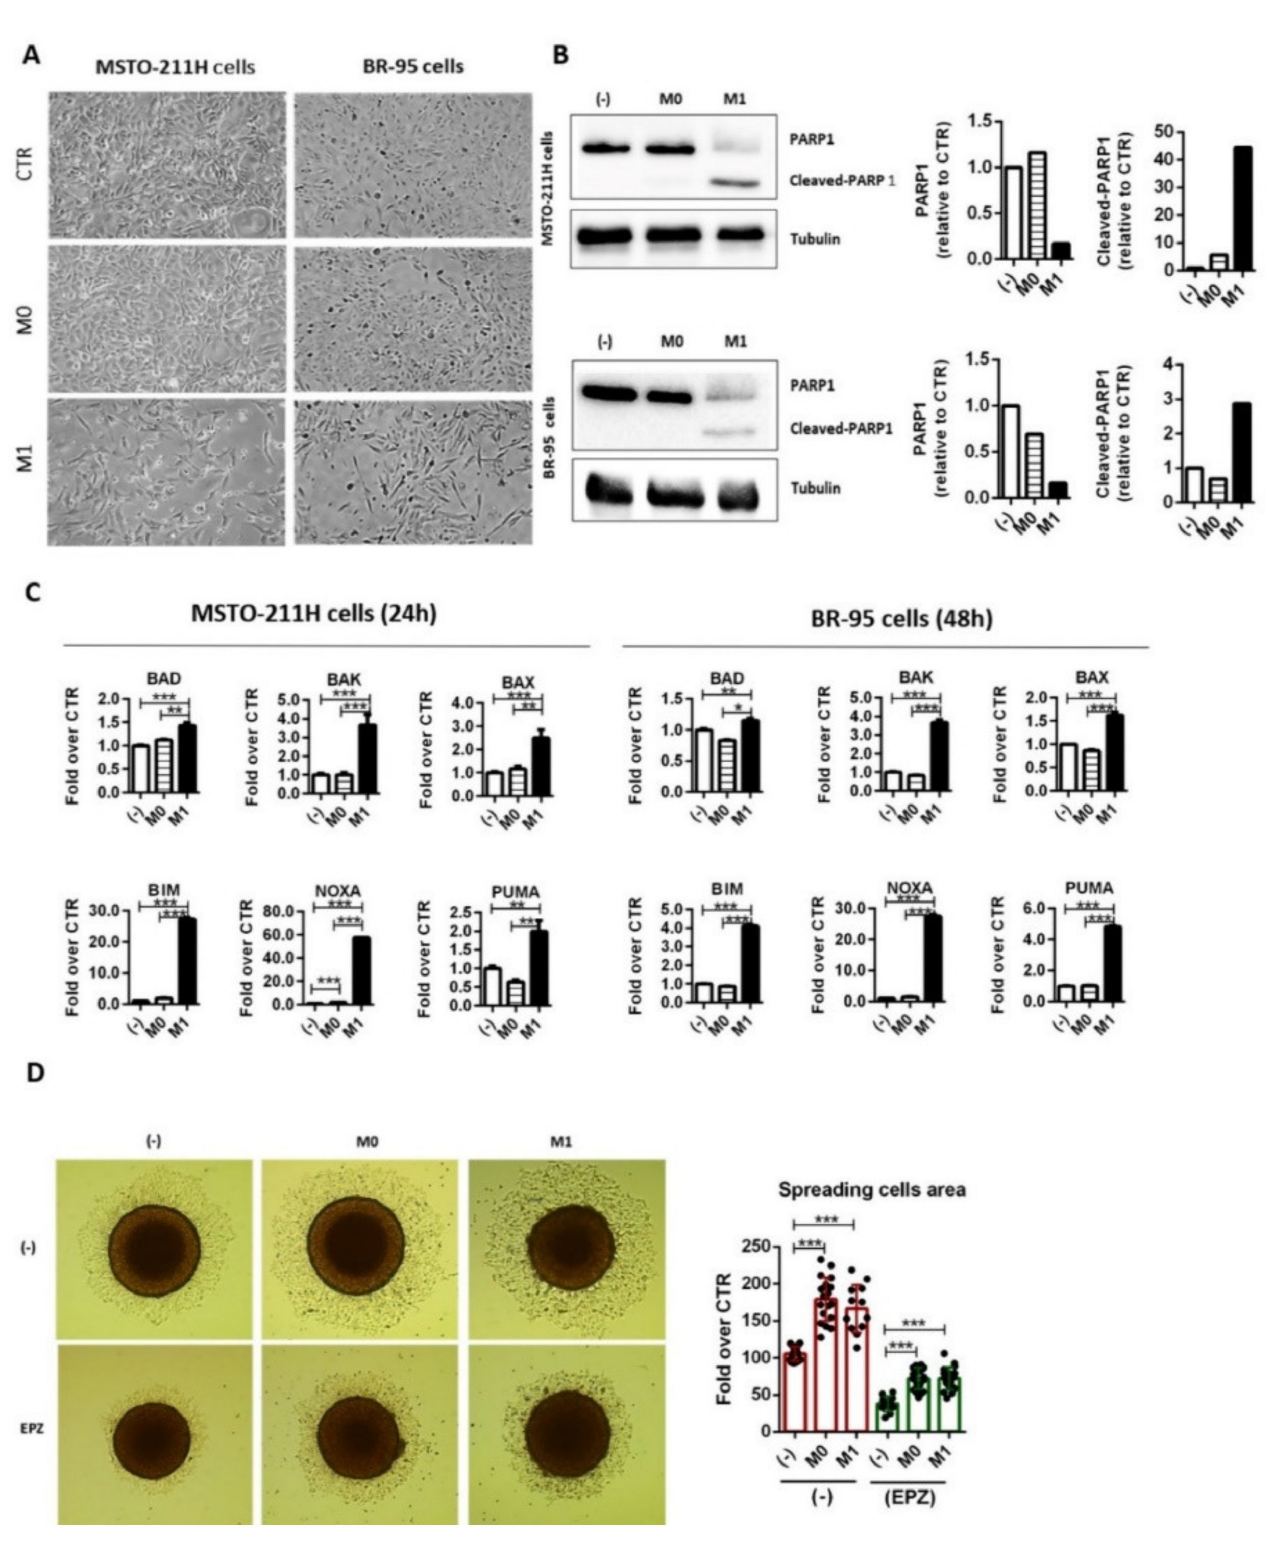
Figure 6. M1-polarized monocytes impair the survival of MPM cells grown as monolayer but not as MCS. ( A , B ) MSTO-211H and BR-95 cells were, respectively, cultured for 48 h or 72 h with 50% of control medium (ctr), M0, and M1-conditioned medium; ( A ) representative optical microscope images are shown. Magnification: 10 × ; ( B ) total proteins were extracted and resolved by 7% SDS-PAGE. PARP1 cleavages were analyzed by Western Blot. Tubulin was used as loading control; ( C ) total RNA was extracted from MSTO-211H cells and BR-95 cells treated with M0 or M1 monocytes-conditioned medium for 24 and 48 h, respectively. Proapoptotic gene expression (BAD, BAK, BAX, BIM, NOXA, PUMA) was evaluated by